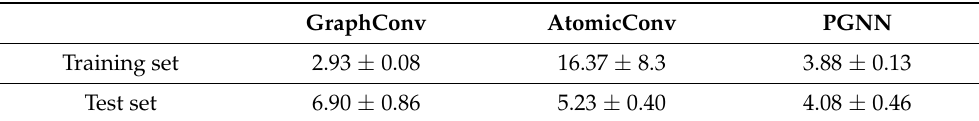
Table 2. Error in calculating ∆∆ G values of the GraphConv model (data-driven), the AtomicConv model (data-driven), and the PGNN model (hybrid) on the PDBbind dataset. RMSE values are in